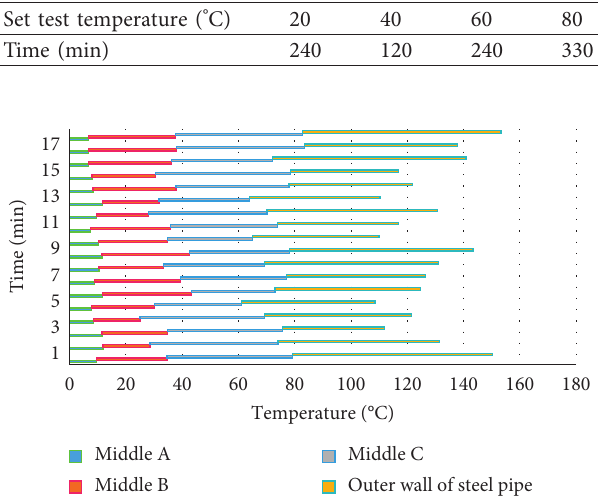
Figure 3: The temperature change trend of each measuring point during the cooling stage with time.